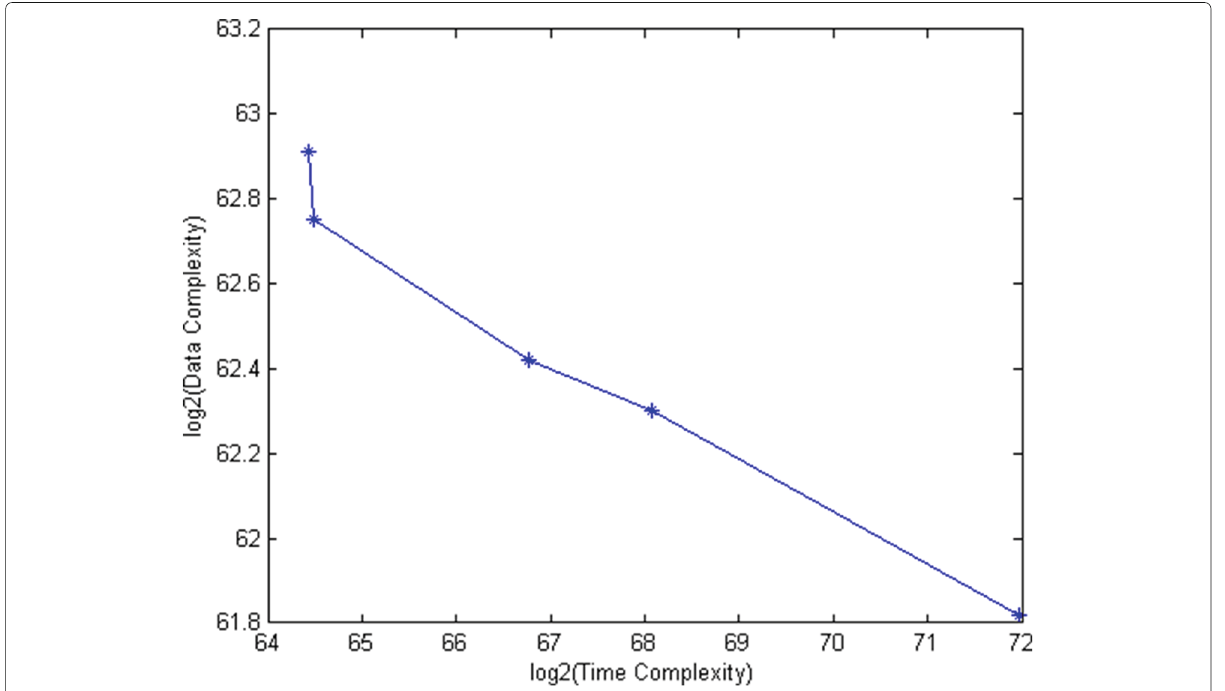
Fig. 3 Data-time tradeoff for the attack on 24-round LBlock